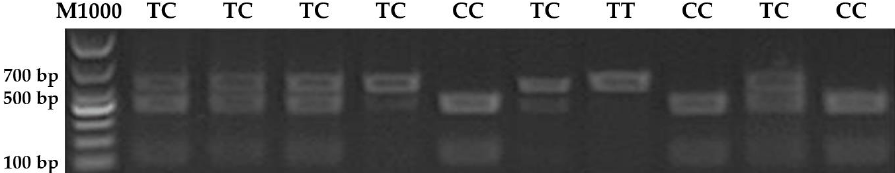
Figure 4. PCR-restriction fragment length polymorphism (RFLP) detection of rs81471943 in Duroc pigs. M1000: DNA marker of 1000 bp. Three genotypes were identified by Bsr B I. PCR products with two digested fragments were CC genotype (565 bp + 75 bp); PCR products with three digested fragments were CT genotype (640 bp + 565 bp + 75 bp); and PCR products with one digested fragment were TT genotype (640 bp).